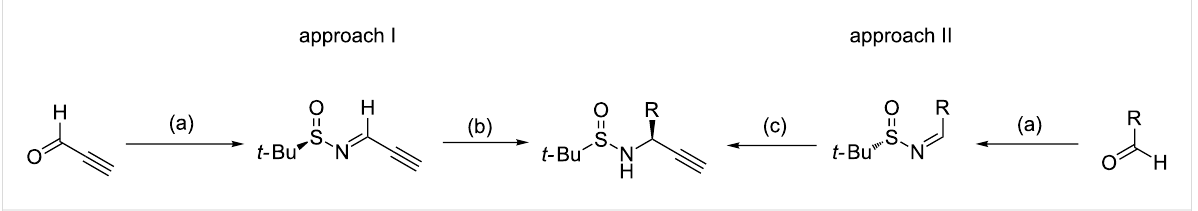
(Figure 3) for the synthesis of enantiomerically pure propargyl- amines by nucleophilic addition. The synthesis of propargyl- amines by diastereoselective reductive amination requires alkynyl ketones, which are difficult to prepare and are unstable towards reductive